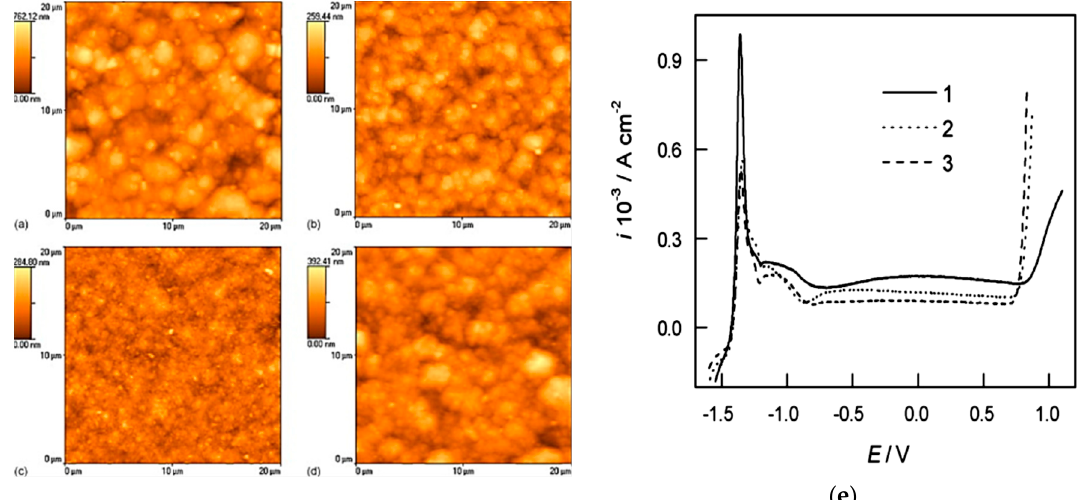
Figure 9. ( a – d ) AFM images for zinc deposited under different current densities values (A/cm 2 ): ( a ) 0.025 (Direct current plating); ( b ) 0.1; ( c ) 0.3; ( d ) 2; ( e ) Polarization curves for nanocrystalline Zn in 0.1 M NaOH solution: (1) Direct plated (2 and 3) pulse plated of 0.2 A/cm 2 at a scan rate of 5 and 20 mV/s, respectively [63].